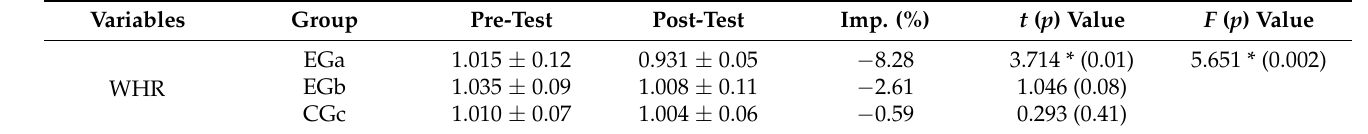
Table 7. The differences in WHR in the experimental